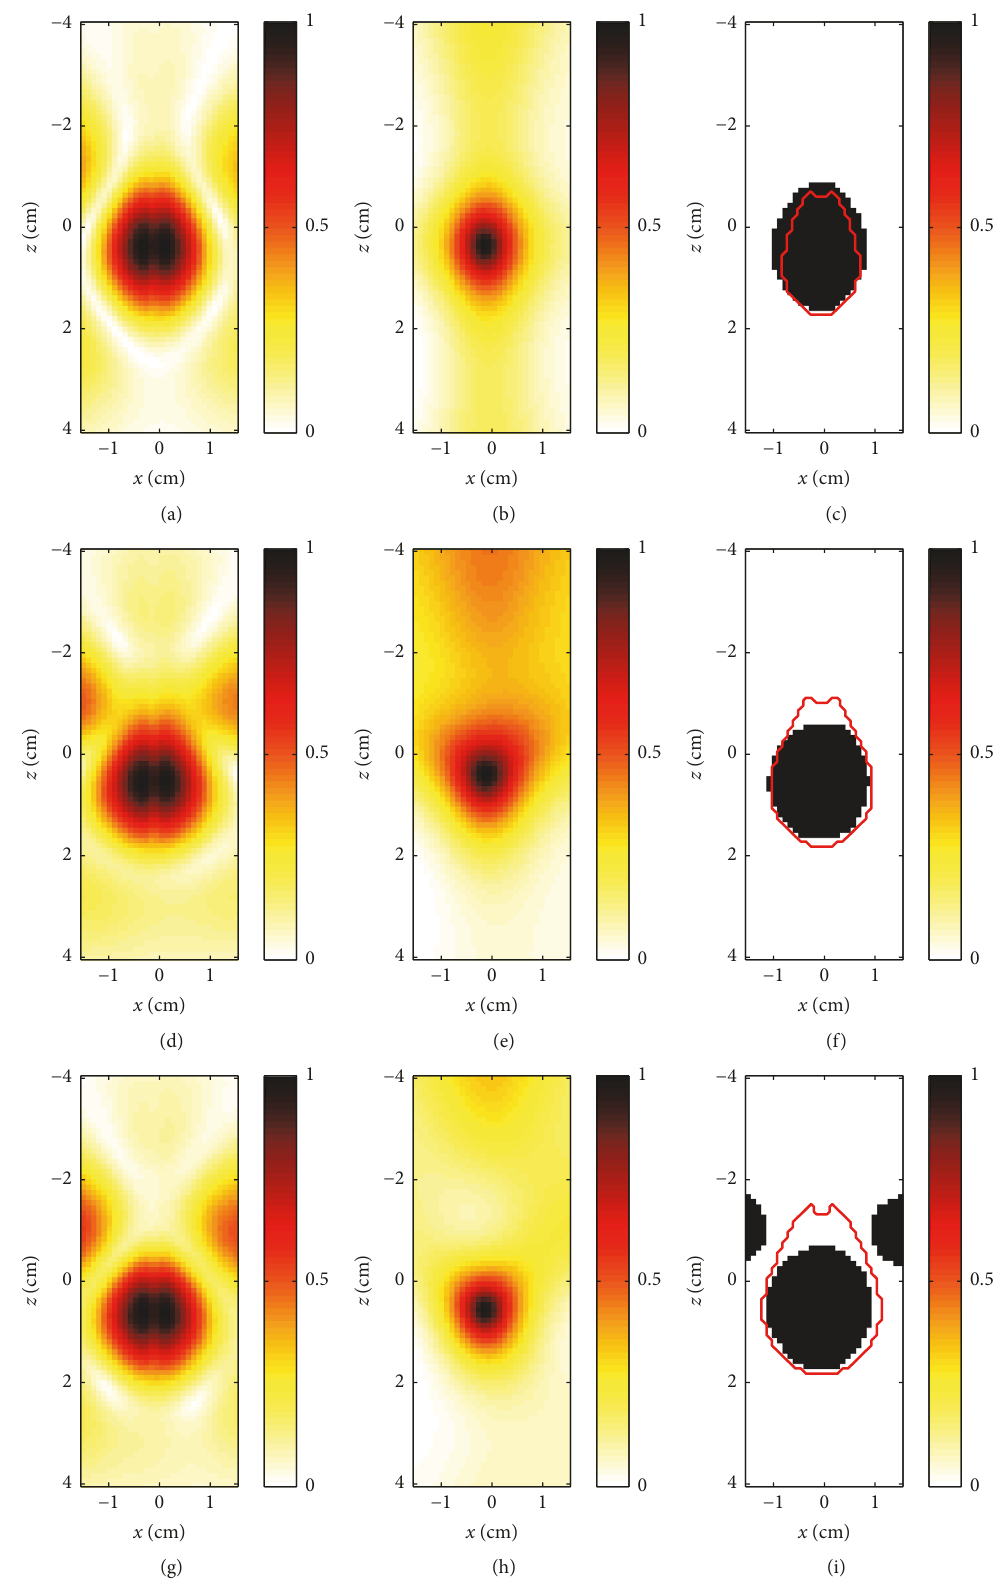
Figure 5: Reconstructions of the electric variations due to the ablation treatment using reduced antennas configuration (consisting of 5 antennas) for the TSVD (a, d, g) and LSM (b, e, h) algorithms and −3 dB cuts of fusion images (c, f, i), at 60 s (a, b, c), 120 s (d, e, f), and 180 s (g, h, i). The shape of the actual ablated area is superimposed (red line) to the fusion